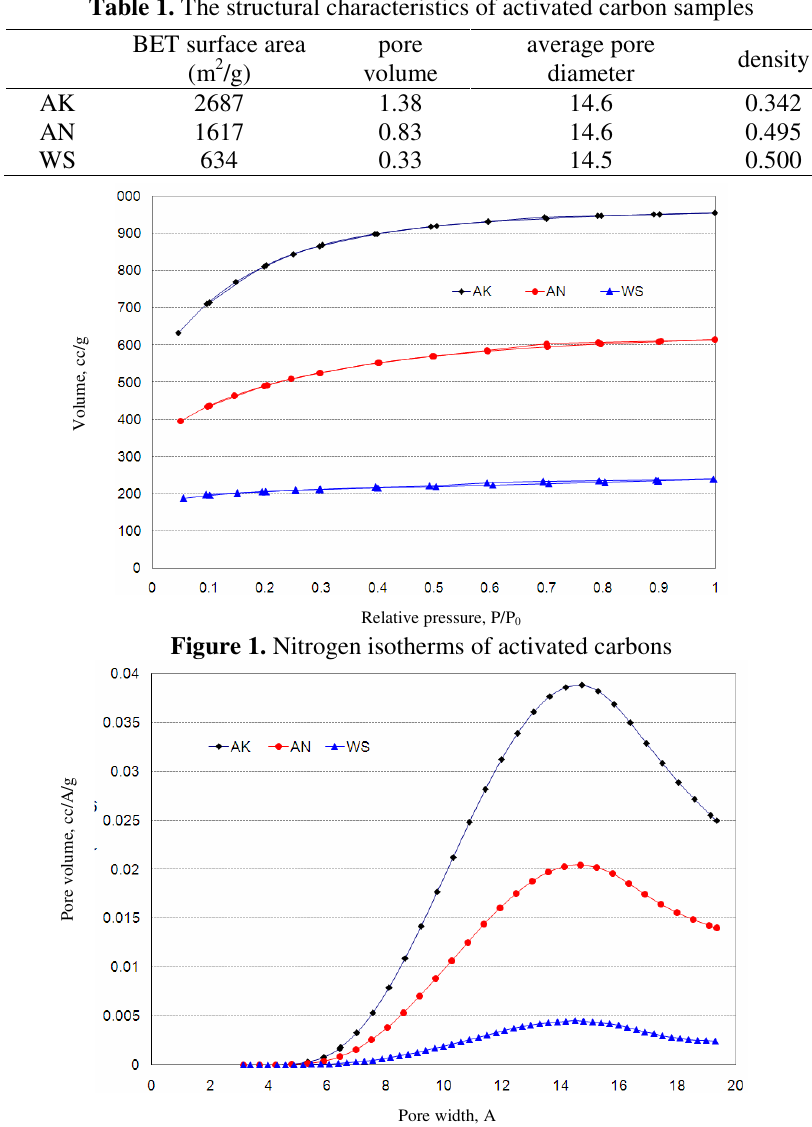
Figure 2. Pore volume distribution of activated carbon samples using HK methods Table 2. The structural characteristics of supported